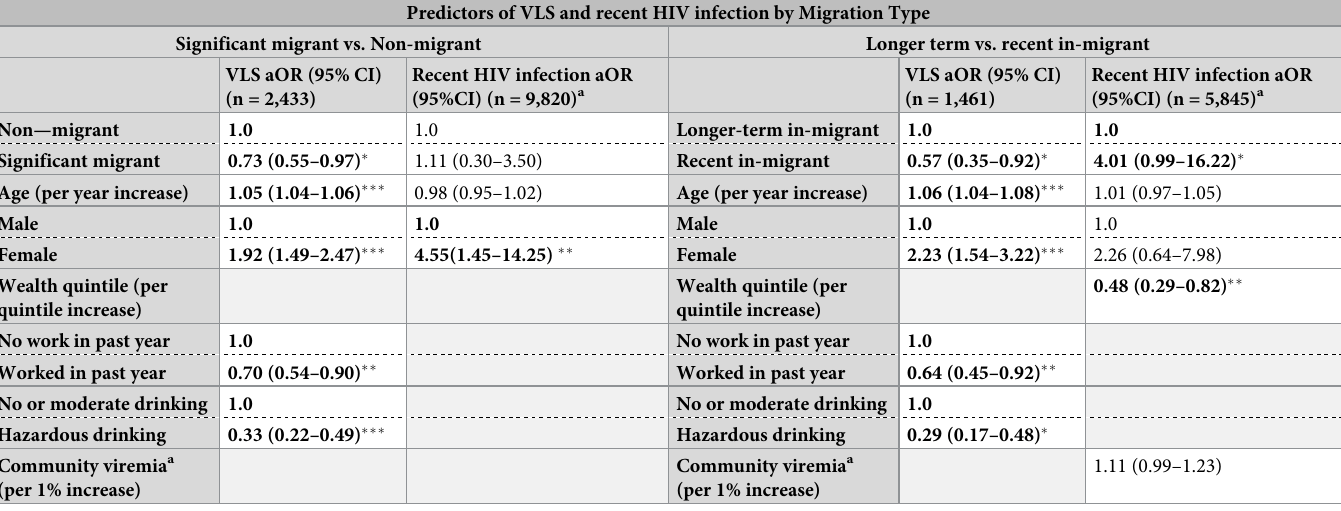
Table 4. Multivariable models of factors predicting recent HIV infection and viral load suppression by migration pattern in the 2017 Namibia Population-based HIV Impact Assessment (NAMPHIA). Predictors of VLS and recent HIV infection by Migration